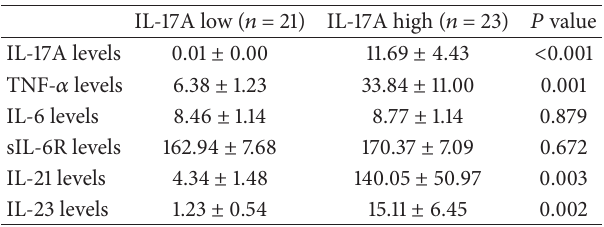
Figure 2: Bimodal distribution of IL-17A levels in the patients. Upper normal value of IL-17A level was defined as the mean serum IL-17A levels + 3SD in healthy controls ( 𝑛 = 12 ). IL-17A levels of RA patients were divided into the IL-17A low ( 𝑛 = 21 ) and high ( 𝑛 = 23 ) groups.Verticallinemarksthecut-offvalue(i.e.,uppernormalvalue of IL-17A levels in the healthy controls). RA = rheumatoid arthritis; HC = healthy controls. Table2:Comparisonof baselineserumcytokinelevelsintheIL-17A low group and the IL-17A high